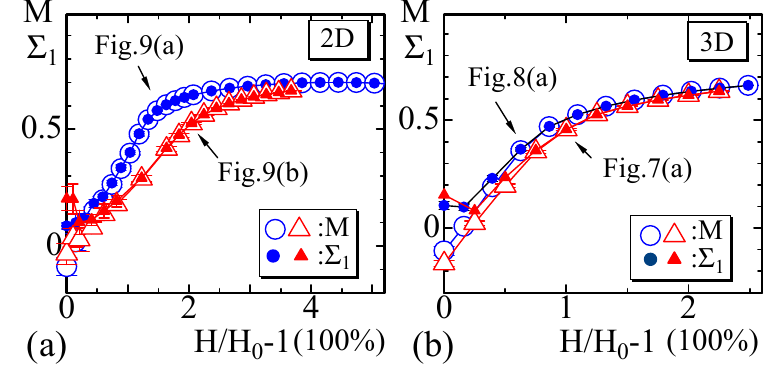
Figure 10. The open symbols in ( a ) 2D and ( b ) 3D simulations represent the order parameter M defined by Equation (17), and the solid symbols represent the largest eigenvalue Σ 1 of the tensor order parameter defined by Equation (18).